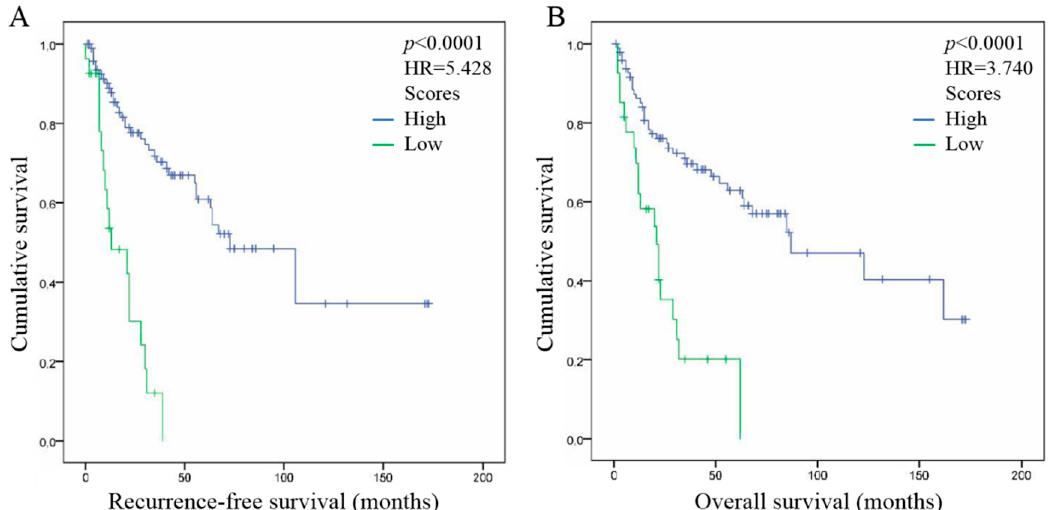
Figure 4. Association between combined Treg infiltration in the stromal compartment, tumor stage and tumor histological grade and prognosis in HNSCC. ( A ) Association between the three combined prognostic markers and recurrence-free survival of HNSCC patients. ( B ) Association between the three combined prognostic markers and overall survival of HNSCC patients. High score means that all the markers or two of the three markers are of good prognosis. Low score means that one of the three markers or none of the three markers are of good prognosis.